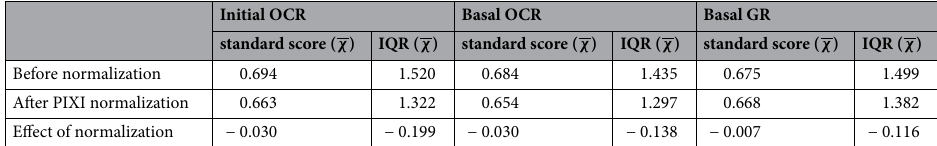
Table 1. Summary of the changes in average standard score and average IQR (represented as χ -bar) after brightfield image PIXI analysis normalization.